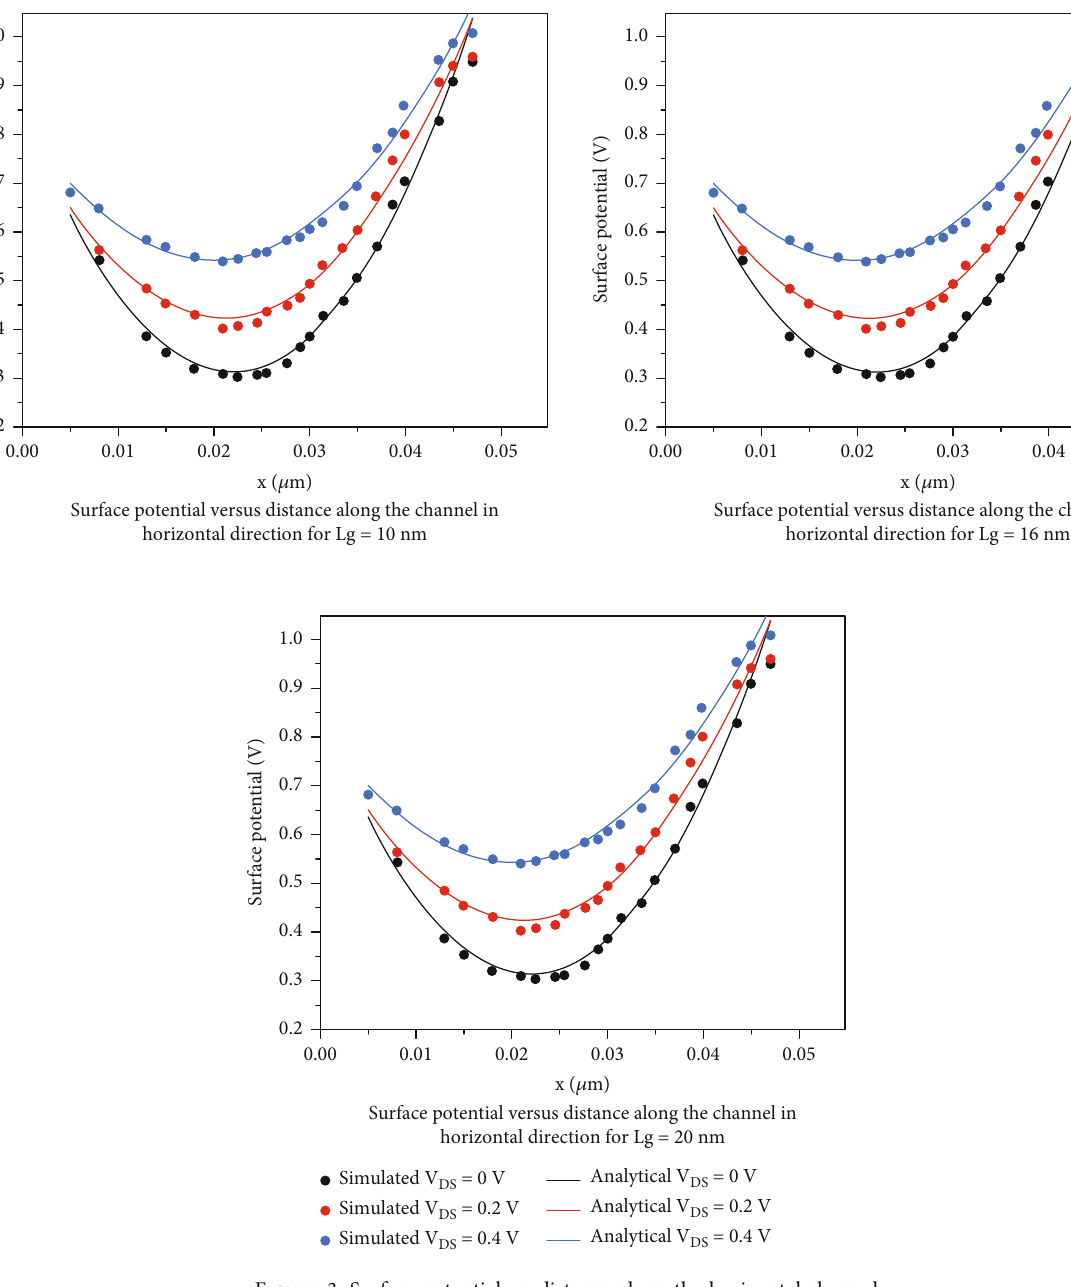
Figure 3: Surface potential vs. distance along the horizontal